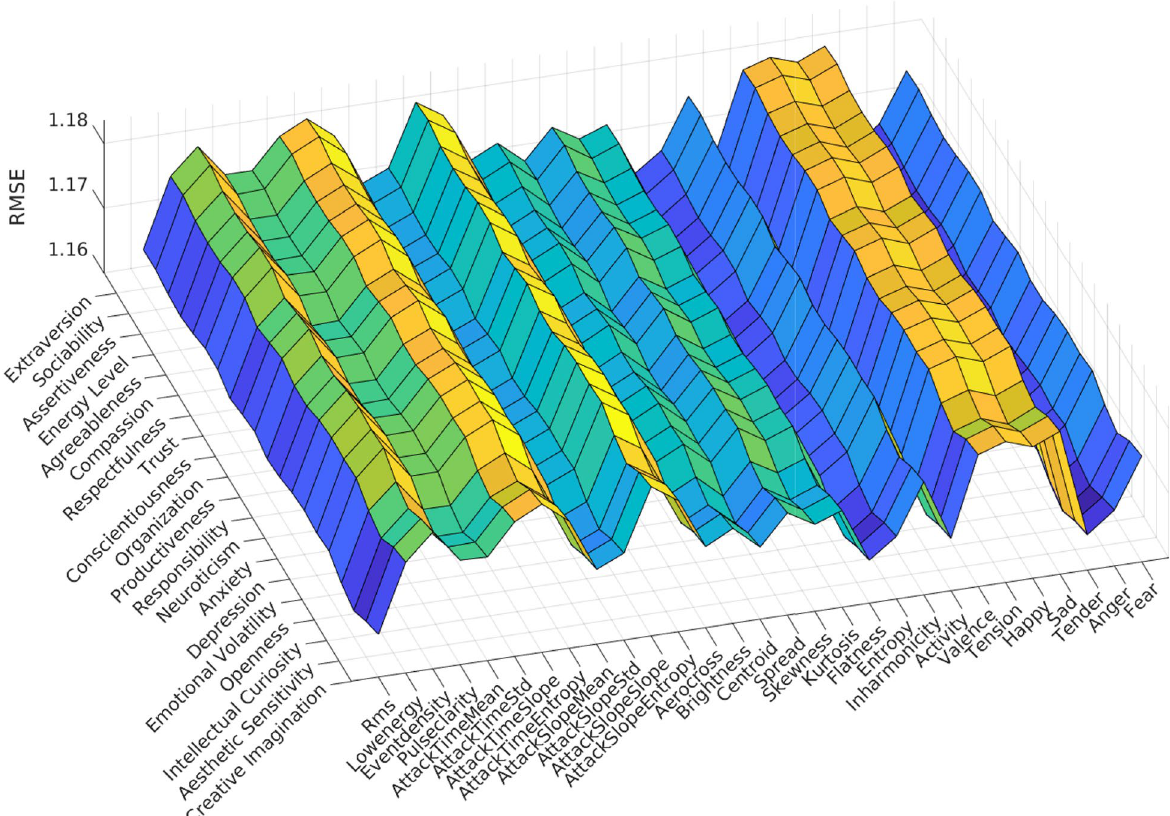
Fig. 6 The prediction error for Q1 ratings using a hybrid model based on the similarity of a single personality trait and a single audio feature. The minimum point (best pair) with respect to the 15 personality facets is obtained for curiosity and tender (RMSE to the Big Five personality domains is obtained for Openness and tender (RMSE